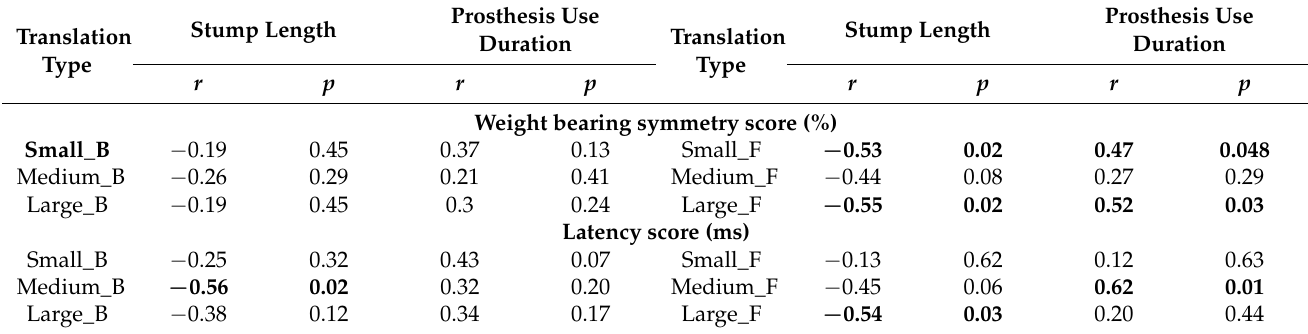
Table 4. Associations between amputation characteristics and outcomes of motor control test.